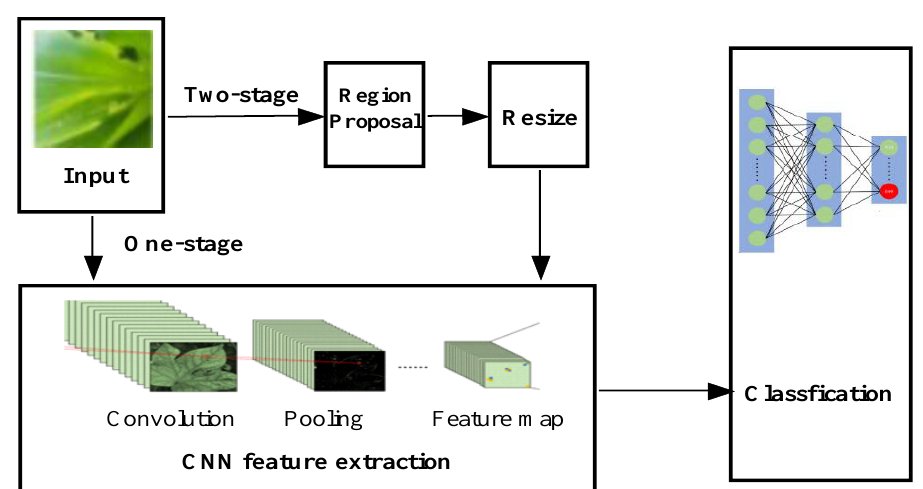
Figure 3. Anchor-based detection method.